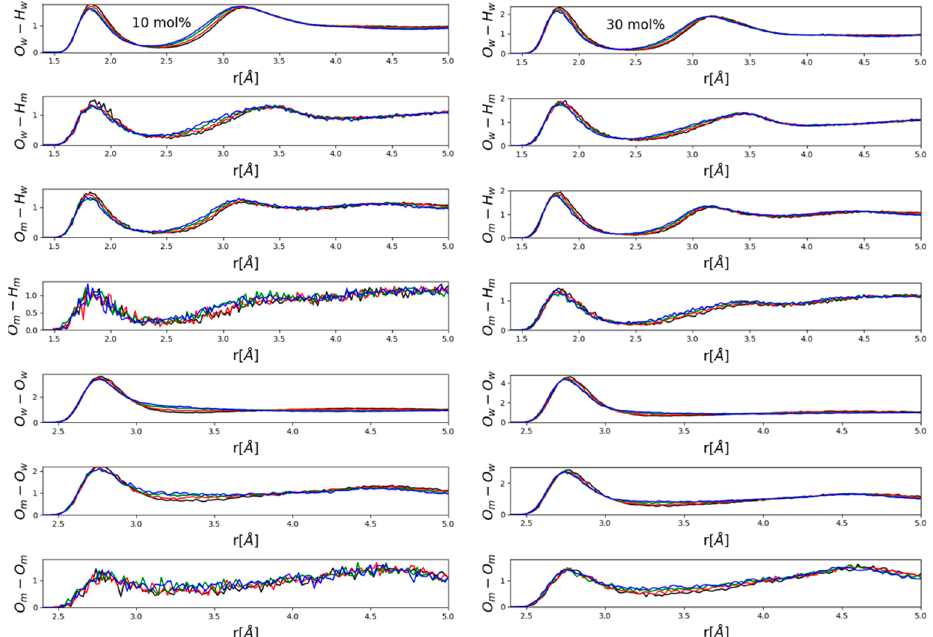
Figure 4. Hydrogen-bonding related partial radial distribution functions in mixtures with low alcohol contents, 10 (left panel) and 30 (right panel) mol% methanol. Black lines: 0.15 GPa; red: 0.4 GPa; green: 0.8 GPa; blue: 1.2 GPa. Indices “m” and “w” refer to “methanol” and “water”, respectively.